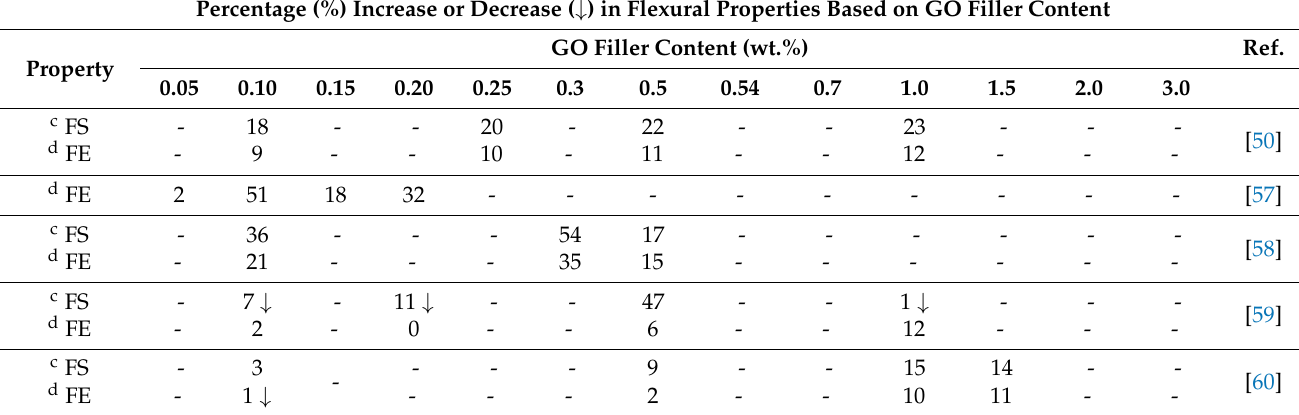
Table 3. A review summary of flexural properties of past research with synthetic epoxy/GO